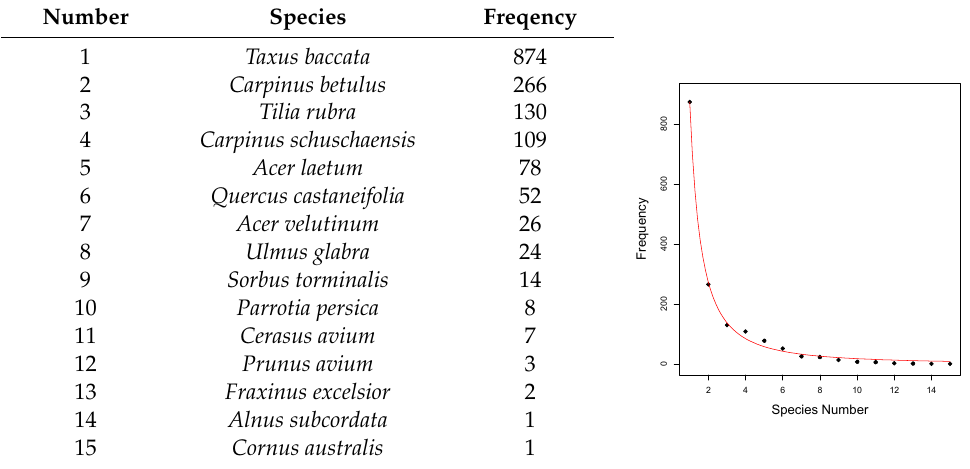
Table 4. Species-specific detail presented separately for each of the three field